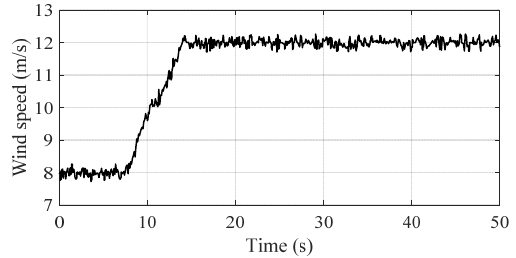
Figure 11. The fluctuating wind speed in case I. The increase in the wind speed leads to the decrease in the PCC voltage amplitude from 0.995 p.u. to 0.966 p.u. when the constant voltage control is only adopted by the DFIG. The impact load caused the voltage of PCC to drop further to 0.96 p.u. The voltage amplitude of PCC is shown in Figure 12.